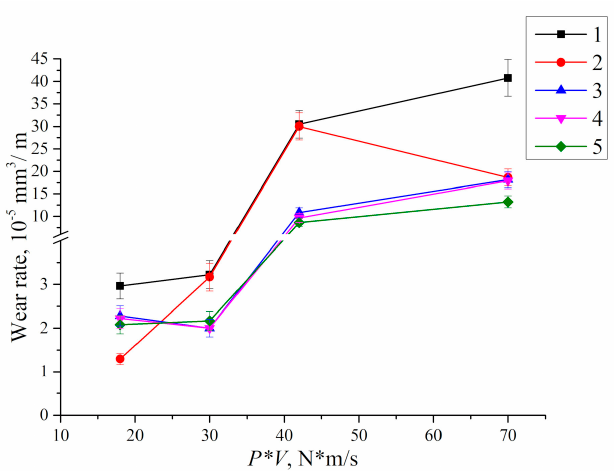
Figure 16. Wear rate vs. P · V tribological loading parameter: 1—UHMWPE; 2—UHMWPE + 0.5% CNF; 3—UHMWPE + 10% CF; 4—UHMWPE + 10% LCF; 5—UHMWPE + 10% HDPE-g-SMA + 2% LCF + 0.5% CNF.